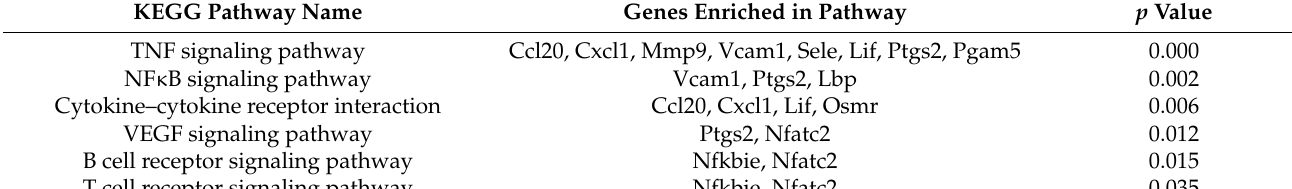
Table 3. The overlapped differentially expressed genes pathway enrichment.